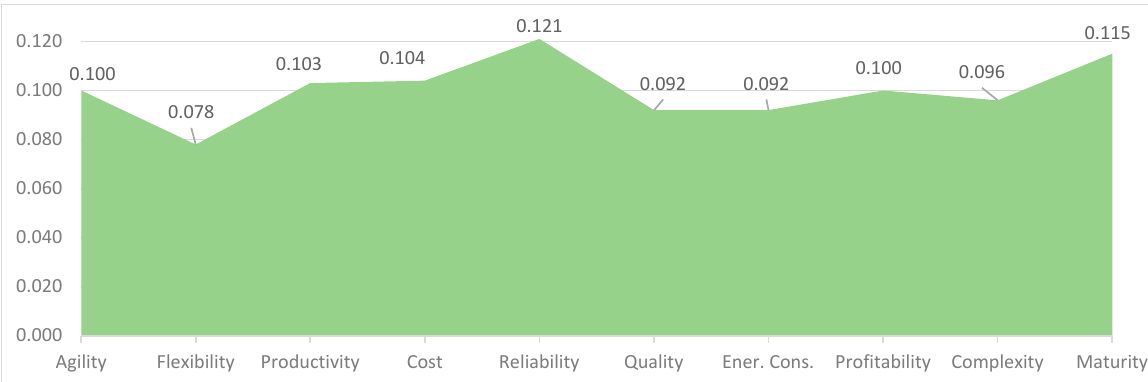
Figure 5. Criteria weighting results.